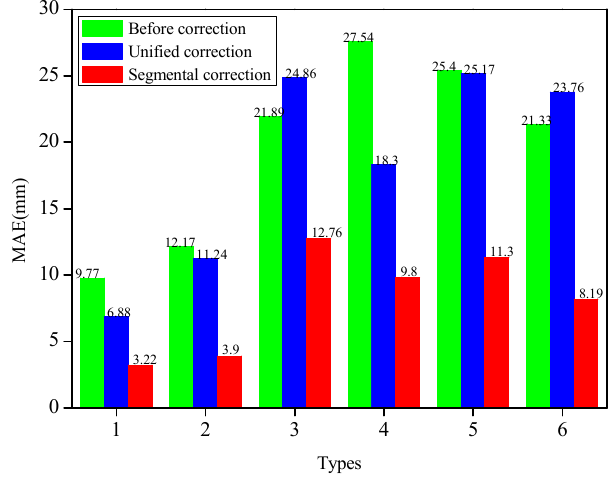
Figure 7. Comparison of MAEs based on different methods under six bending shapes.